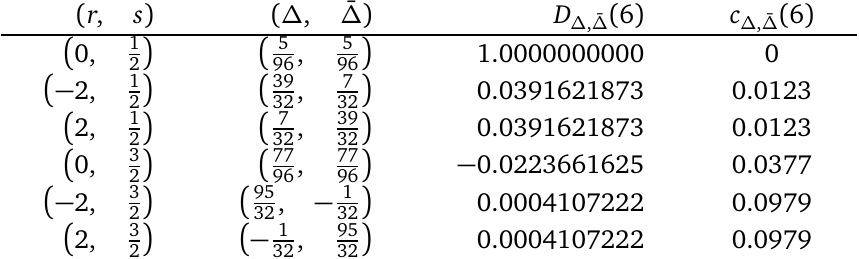
to N = 6 states at c = 0. 2 (cid:90) , (cid:90) + 1 2